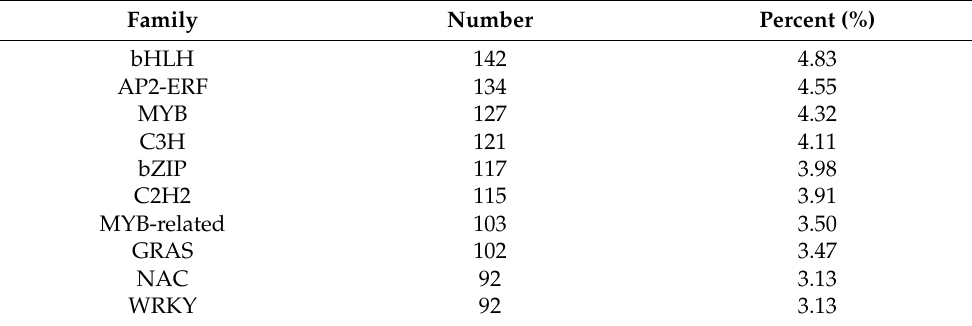
Table 2. Top 10 TF families in Chosenia arbutifolia transcriptome sequences.